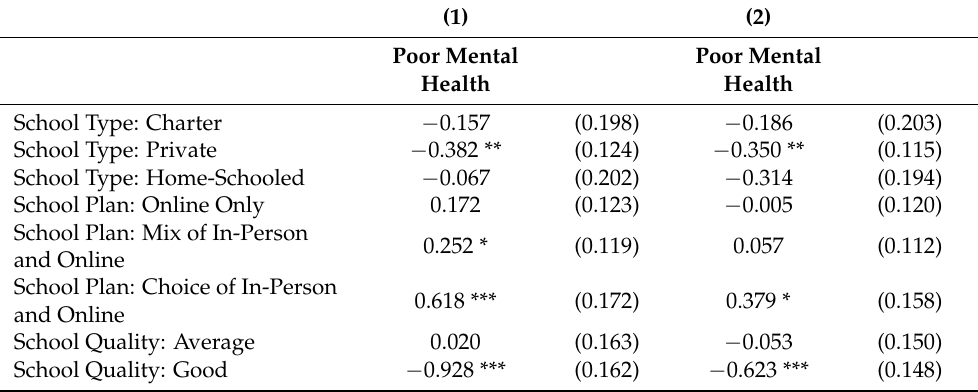
Table 2. Parent mental health during COVID-19: controlling for prior mental health (ordered logistic multivariate regression